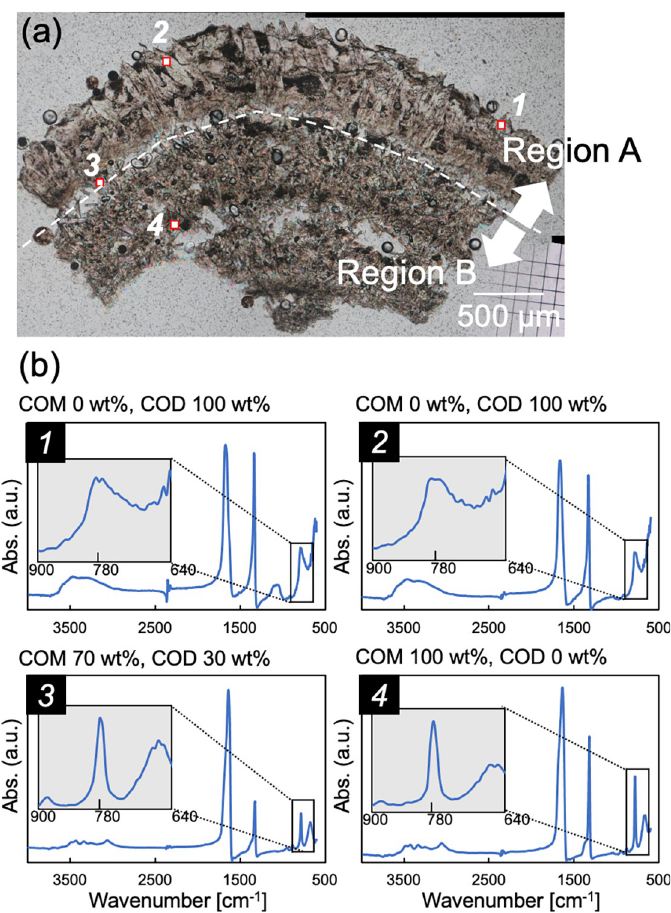
Fig 4. (a) An open-Nicol image of the second section of sample #1004. Red marks and numbers : the FTIR measurement points. (b) The measurement results for each measurement point obtained by FTIR microscopy. The inner graphs are the enlarged views of the peaks at 780 cm − 1 in each graph, and the ratio of COM to COD in the upper part of the graph shows the ratio calculated by the analytical method derived in this